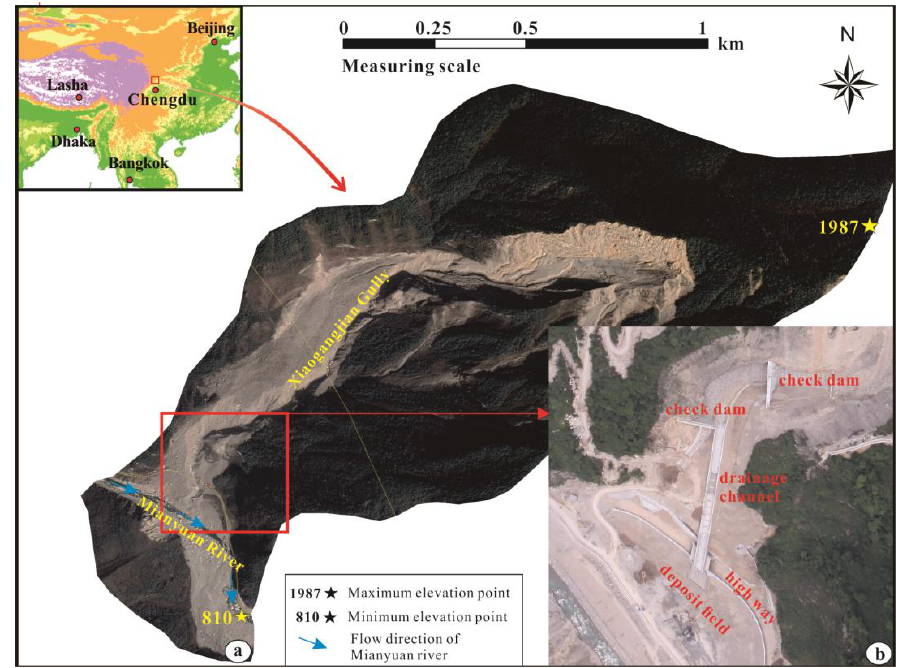
Figure 1. Location of Xiaogangjian gully and its full view. ( a ) Remote sensing image of Xiaogangjian’s watershed in 2010 and ( b ) layout of the downstream mitigation works in 2011.